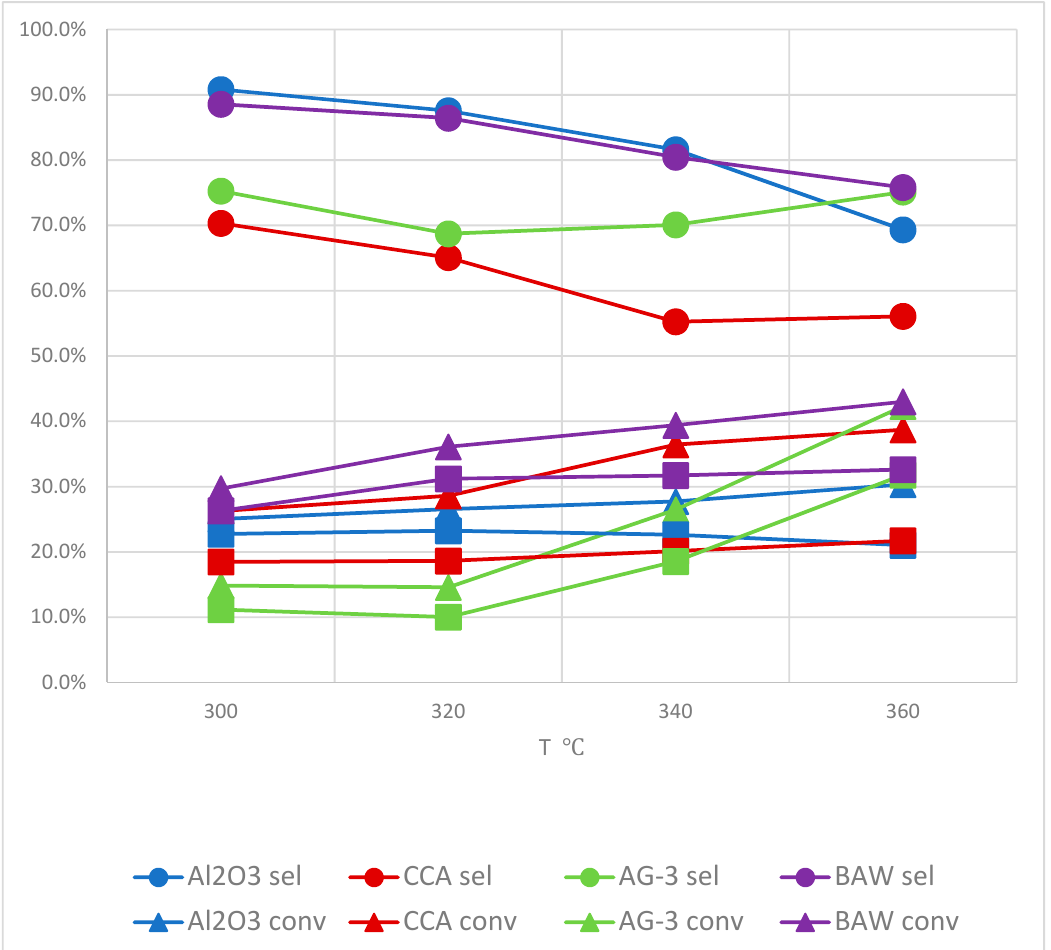
Figure 2. Catalytic performance of the KCoMoS 2 catalysts on the various support materials. Triangles: CO conversion; Spheres: total alcohol selectivity; Squares: total alcohol yield. Data for the individual alcohols can be found in Table S1.